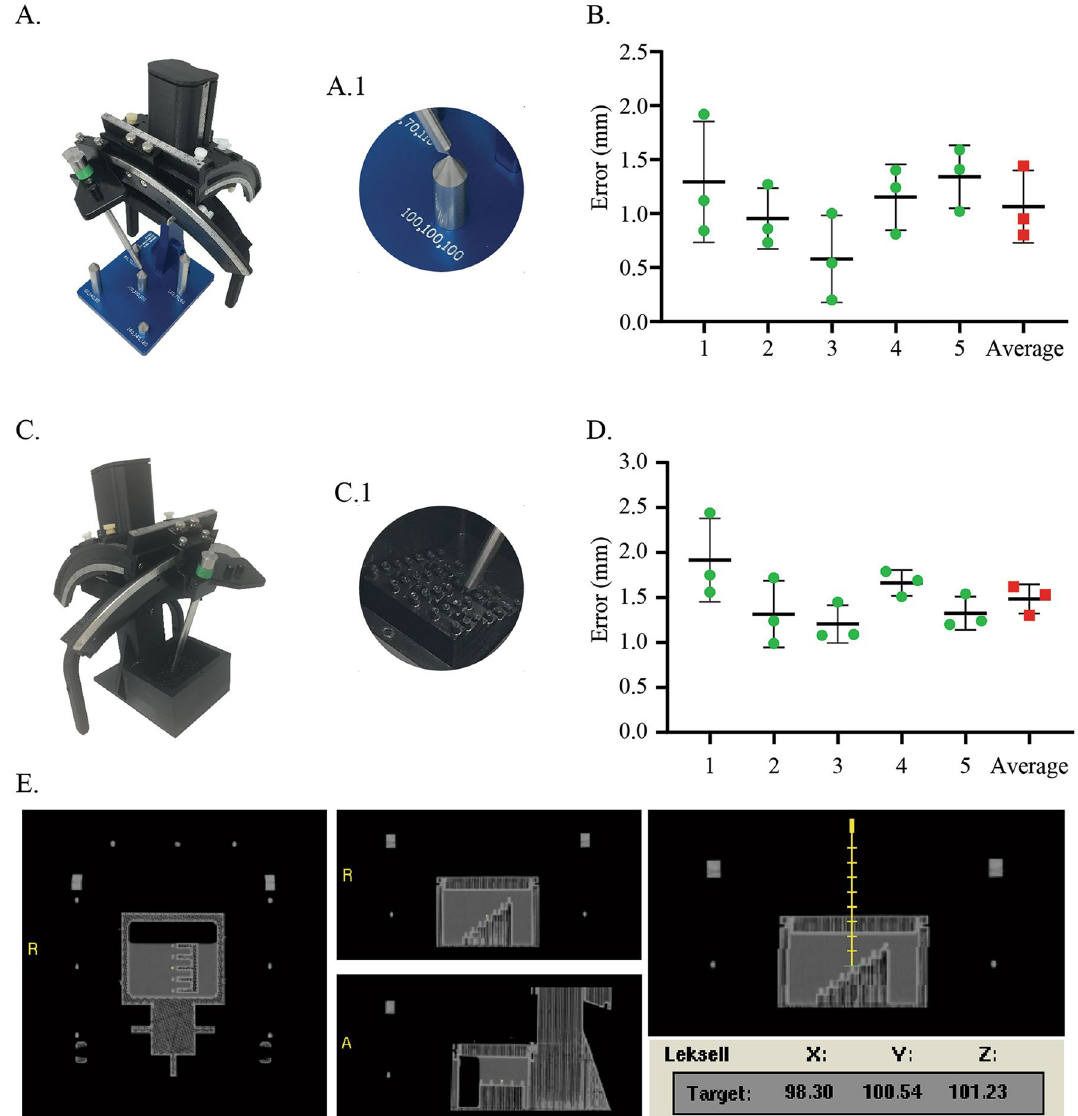
Figure 2. Mechanical and imaging accuracy tests. ( A ) Mechanical accuracy test fixture with zoomed in view of the conical tip being targeted ( A.1 ) shown inset. ( B ) Mechanical accuracy test results for all 5 targets (3 independent observers per target). ( C ) Imaging accuracy test fixture with inset ( C.1 ) showing all available target points. ( D ) Imaging accuracy test results for 5 target points selected to provide maximal coverage of the work envelope. ( E ) Snapshot of COMPASS surgical planning software showing targeting of a representative point (yellow dot and trajectory line) on imaging test fixture and its coordinate situated ~ 60 mm below the skull surface 22 . The third ventricle extends a few cm below the frontal horns. This is covered well by the Z dimension (80 mm) of the work envelope whose upper limit begins at ~ 22.5 mm below the skull surface. In addition, its large Y dimension (110 mm) provides extensive antero-posterior coverage of the frontal horns. In addition, this wide work envelope could facilitate other procedures like catheter-based hematoma evacuation, quick brain biopsies, and intracranial pressure monitor placement. Catheter implantations were performed in < 30 min. Increased procedure time is a major deterrent to adop- tion of image guided and stereotactic surgical systems for EVD placement. In a large survey of ventriculostomy practices, 94% practicing neurosurgeons and 93% residents said they would not use an image-guided system if it added more than 10 min to the procedure time 11 . Time economy was thus a major thrust of our system’s design. The clamp mechanism for securing the EVD key, use of an N-bar fiducial system (which is automatically detected by surgical planning software), the small footprint of the device, and the user-friendly mechanics facili- tate an expeditious procedure. On average, EVD key implantation and surgical planning (fiducial registration and target/trajectory selection) were found to take about 1.6 and 9.4 min respectively. This is an improvement over the set up and registration time of electromagnetic neuro-navigation (frameless stereotaxy) which has been found to take approximately 34 min 14 . An advantage of electromagnetic neuronavigation over our system,